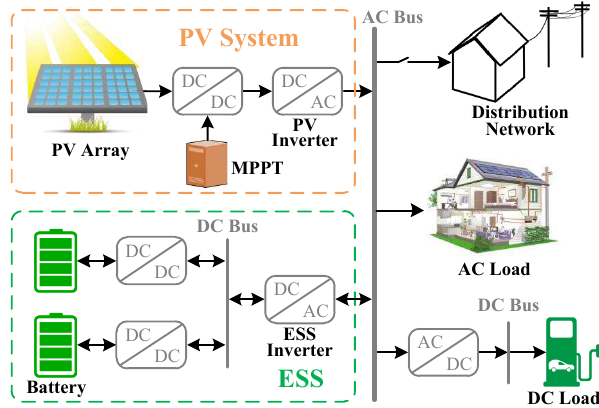
Figure 1. Structure of master–slave-organized islanded microgrid.